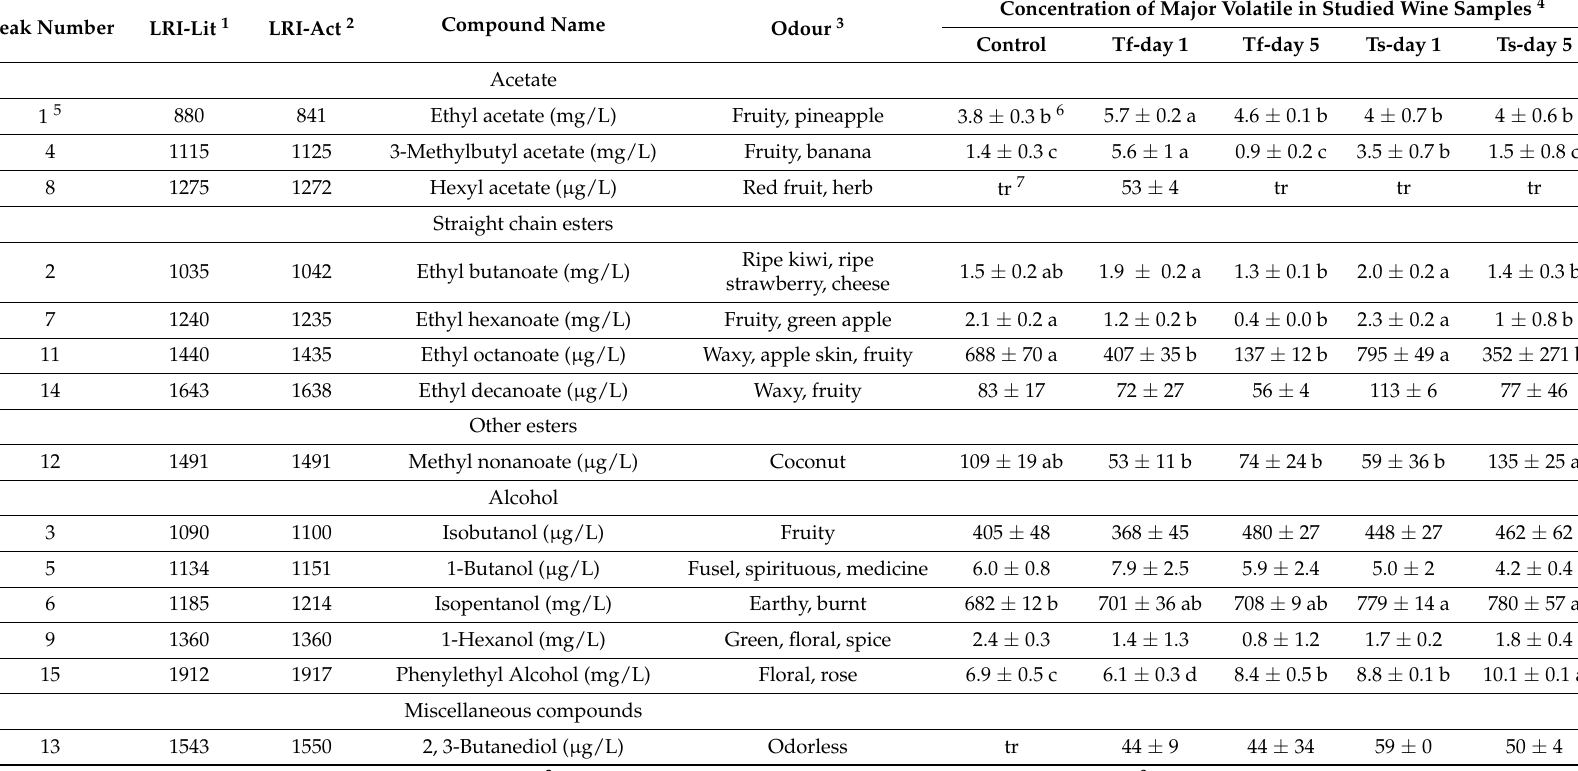
Table 2. Major wine volatiles detected for the wines made in small-scale fermentations ( p <